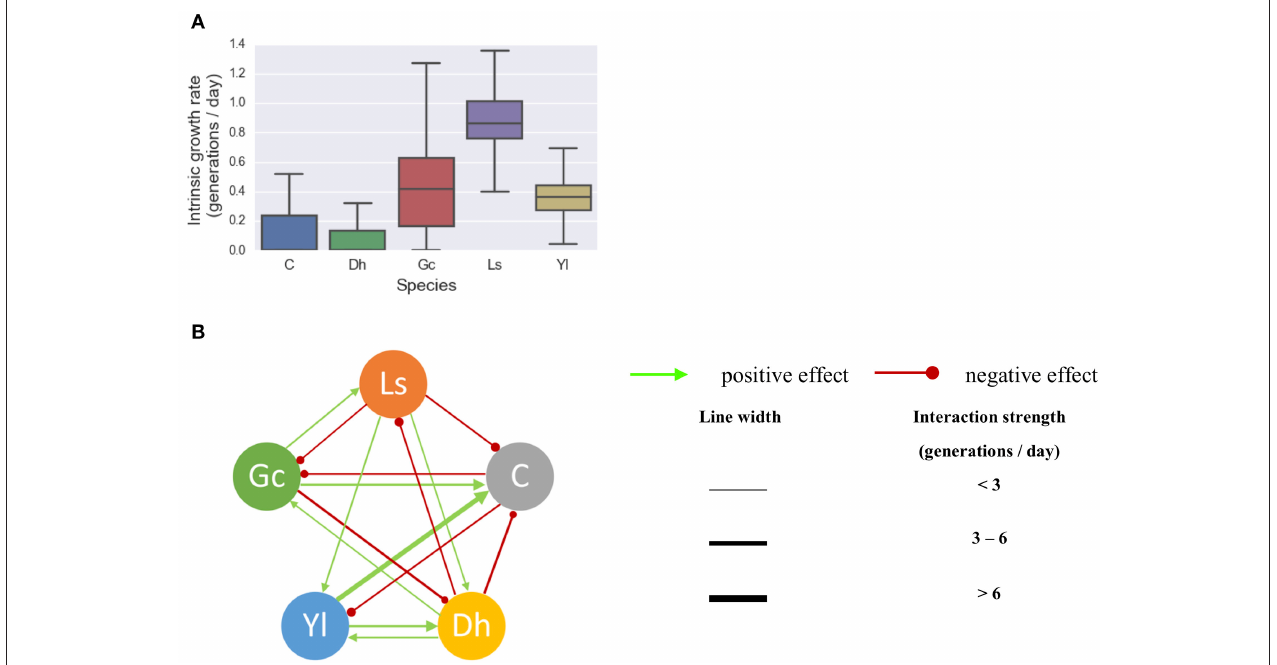
FIGURE 3 | Inferring significant microbial interactions within a cheese microbial community. (A) The intrinsic growth rates of the microbes and (B) their significant interactions were inferred from the longitudinal data of five microbes. 80% of the whole data set was randomly selected for training the gLV model, with 1,000 bootstrap samples. Resulted interactions were selected with one-sample t -test P ( a ij 6= 0) > 95%. The line thickness is proportional to the strength of the interaction. Dh, D. Hansenii ; Yl, Y. Lipolytica ; Gc, G. Candidum ; Ls, Leucobacter sp .; C, a bacterial group includes Arthrobacter arilaitensis , Hafnia alvei , Corynebacterium casei, Brevibacterium aurantiacum , and Staphylococcus xylosus